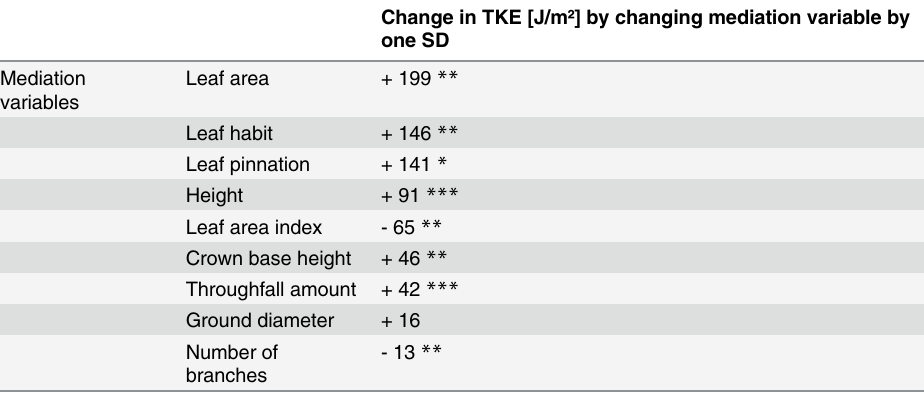
Table 2. Effect sizes of mediation variables (leaf and tree architectural traits). Change in TKE [J/m²] by changing mediation variable by one SD Mediation Leaf area + 199 ** variables Leaf habit + 146 ** Leaf pinnation + 141 * Height + 91 *** Leaf area index - 65 ** Crown base height + 46 ** Throughfall amount + 42 *** Ground diameter + 16 Number of - 13 ** branches Values are predicted from mixed effect models for throughfall kinetic energy (TKE) with basic design structure (not shown, see S1 Table). For abbreviations of traits see Table